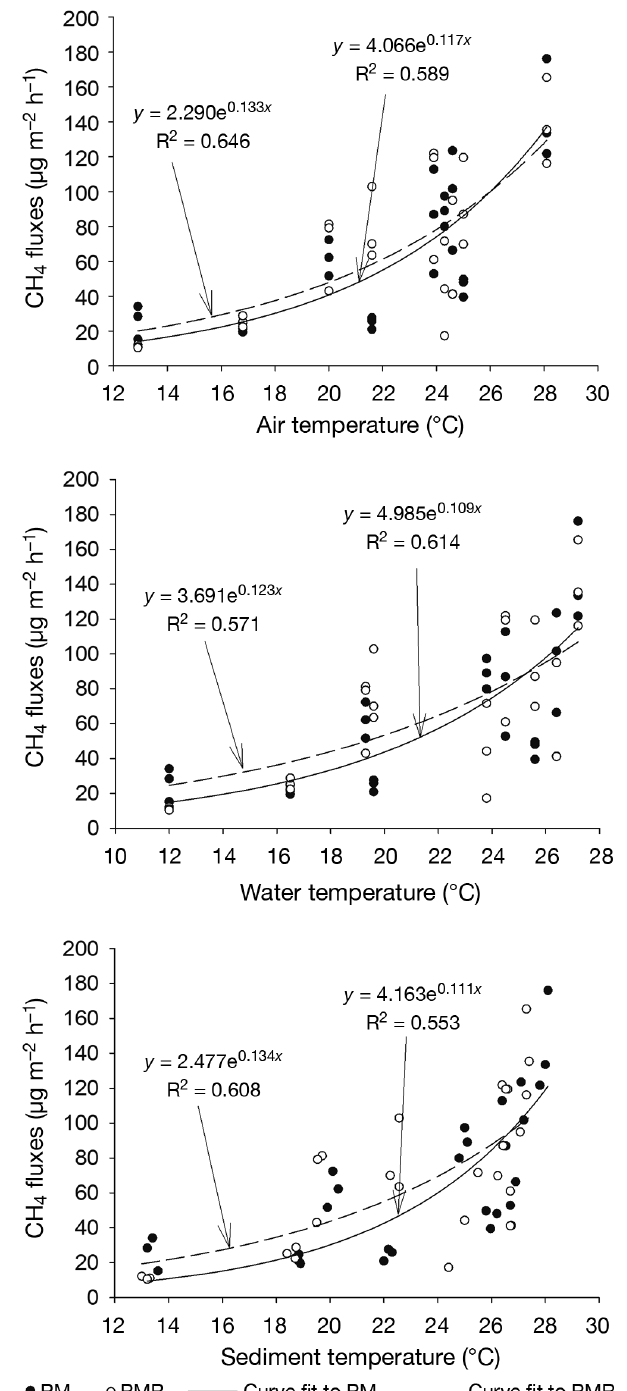
Fig. 3. Relationships between methane (CH 4 ) fluxes and air, water and sediment temperature in the PM and the